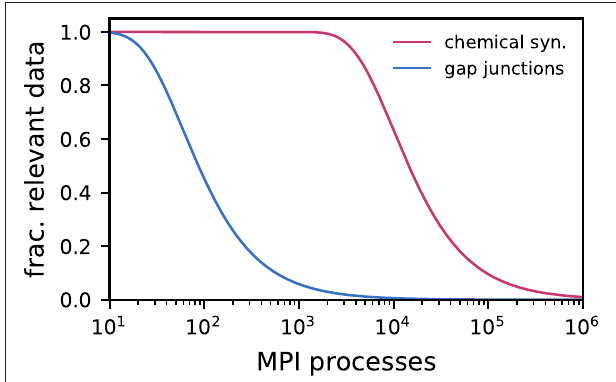
FIGURE 1 | Fraction of activity data relevant for a given MPI process decreases as a result of increasingly sparse connectivity. In weak-scaling scenarios, the fraction of relevant spike data (pink) and gap-junction data (blue) decreases as the number of MPI processes and thus the total network size increases: an ever smaller fraction of the data produced by the network is relevant for the synapses and neurons represented locally on a given MPI process. The effect is more pronounced for gap-junction data than for spike data due to the difference between the typical numbers of gap junctions and chemical synapses per neuron. Here, we assume N M = 10,000 neurons per MPI process and either K = 10,000 incoming chemical synapses per neuron (pink) or K gap = 60 gap junctions per neuron (blue) respectively. See Supplementary Material for